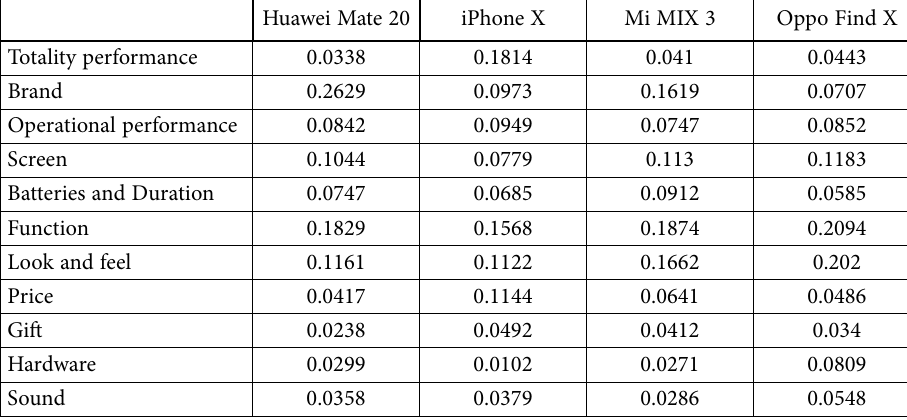
Table 13. The integrated weight matrix